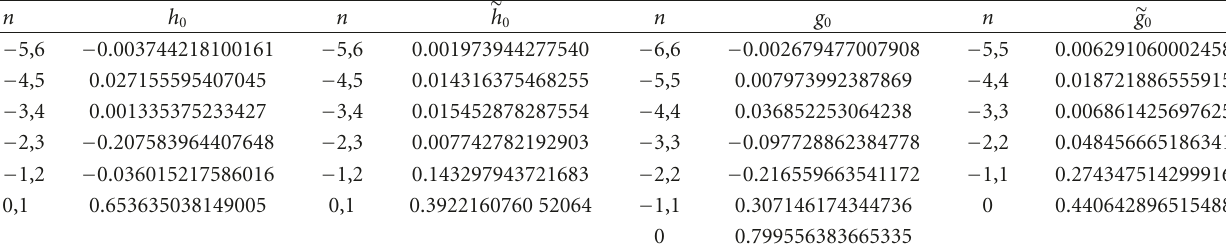
Table 1: The filter coe ffi cients in Example